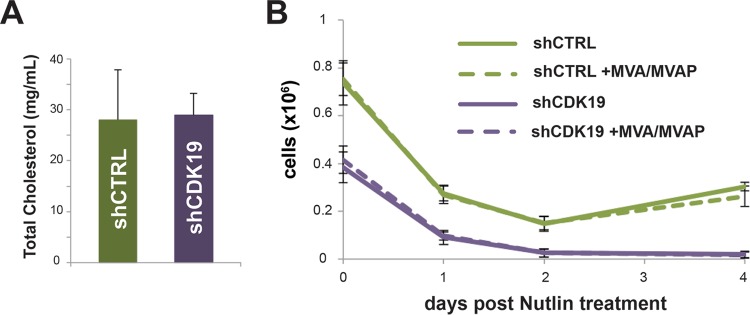
Analysis of cholesterol in shCTRL versus shCDK19 cells. (A) Total cholesterol levels in each cell line. (B) Supplementation of culture media with MVA and MVAP, which are cholesterol biosynthesis intermediates, did not affect cell recovery after treatment with nutlin-3.